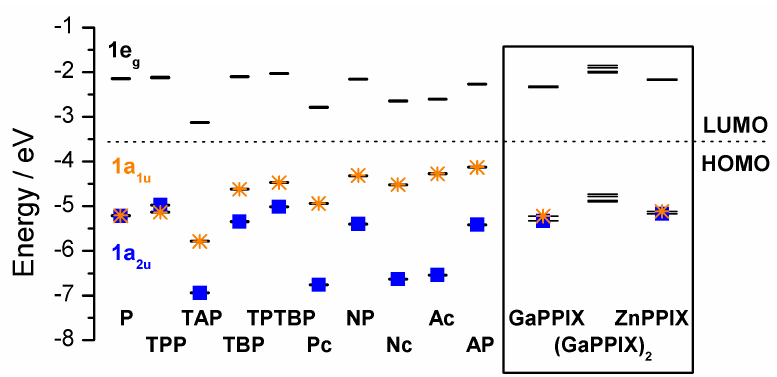
Figure 11. Comparison between the orbital energy levels (horizontal lines) of the “Gouterman” 4-orbitals for a range of porphyrin and phthalocyanines. The “*” marks the a 1u orbital. The key to the abbreviations is in the caption to Figure 9. The black box highlights the molecular orbitals energy levels of the GaPPIX, ZnPPIX, and the (GaPPIX)2. Reproduced with permission of American Chemical Society [100].